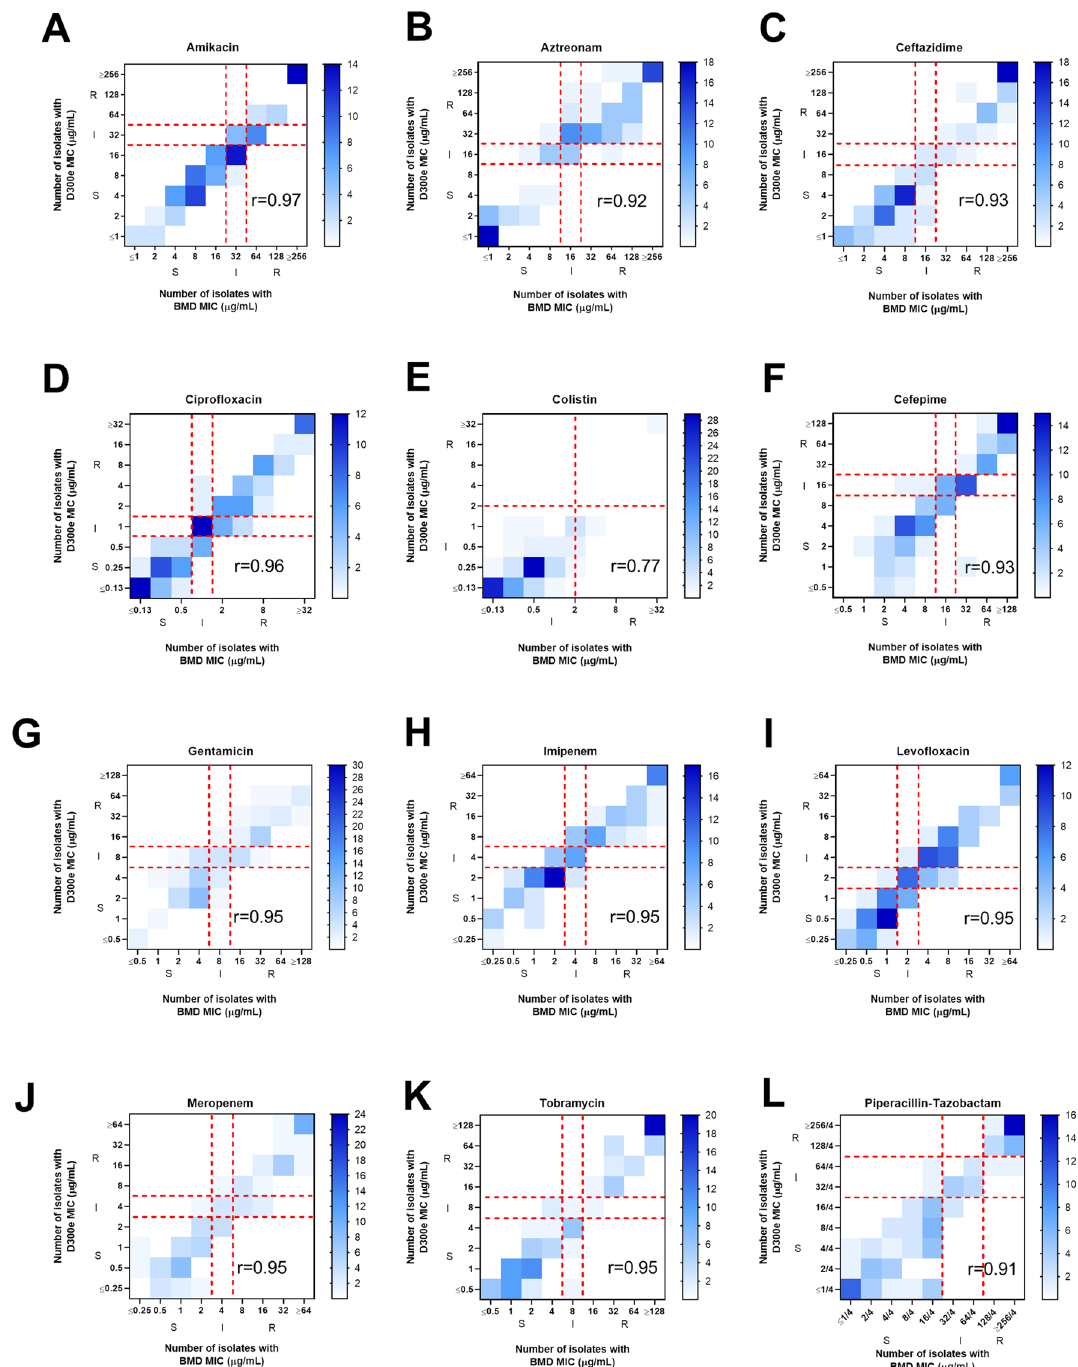
Figure 1. Scattergrams of the D300e and rBMD MIC comparisons (µg/mL). ( A ) amikacin, ( B ) aztreonam, ( C ) ceftazidime, ( D ) ciprofloxacin, ( E ) colistin, ( F ) cefepime, ( G ) gentamicin, ( H ) imipenem, ( I ) levofloxacin, ( J ) meropenem, ( K ) tobramycin, ( L ) susceptible, intermediate and resistant as denoted by CLSI (range: 18.0 to 49.0%) (Fig. 2). This was particularly true of MICs measured for AMK, IPM and LVX, with 42.0, 46.0 and 49.0% of isolates tested having an MIC that fell within the 3 log 2 dilution breakpoint range. The clustering of isolate MICs among the interpretive breakpoints was also reflected in the overall categorical agreement (CA) parameters. The average overall CA between D300e and rBMD panels was 87.0% (82.9–90.9, 95% CI), with the lowest CA being reported for AMK and ATM (at 78.0 and 79.0% CA respectively). This led to only 3 of the 12 antimicrobials tested meeting acceptable ≥ 90% CA criteria. When accounting for the high proportion of CA discrepancies resulting from MIC shifts occurring within the acceptable ± 1log 2 dilution per- formance of BMD tests (measurements in EA), we noted significant CA improvement, reaching ≥ 90% CA for